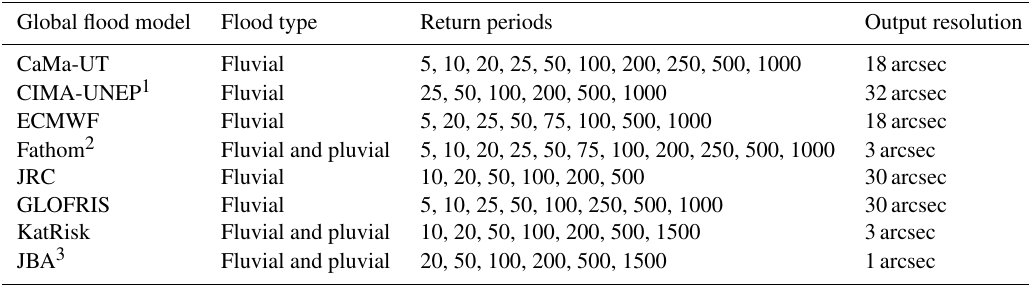
Table 1. Technical specification of the flood hazard maps of the eight GFMs. Global flood model Flood type Return periods Output resolution CaMa-UT Fluvial 5, 10, 20, 25, 50, 100, 200, 250, 500, 1000 18arcsec CIMA-UNEP 1 Fluvial 25, 50, 100, 200, 500, 1000 32arcsec ECMWF Fluvial 5, 20, 25, 50, 75, 100, 500, 1000 18arcsec Fathom 2 Fluvial and pluvial 5, 10, 20, 25, 50, 75, 100, 200, 250, 500, 1000 JRC Fluvial 10, 20, 50, 100, 200, 500 GLOFRIS Fluvial 5, 10, 25, 50, 100, 250, 500, 1000 KatRisk Fluvial and pluvial Fluvial and